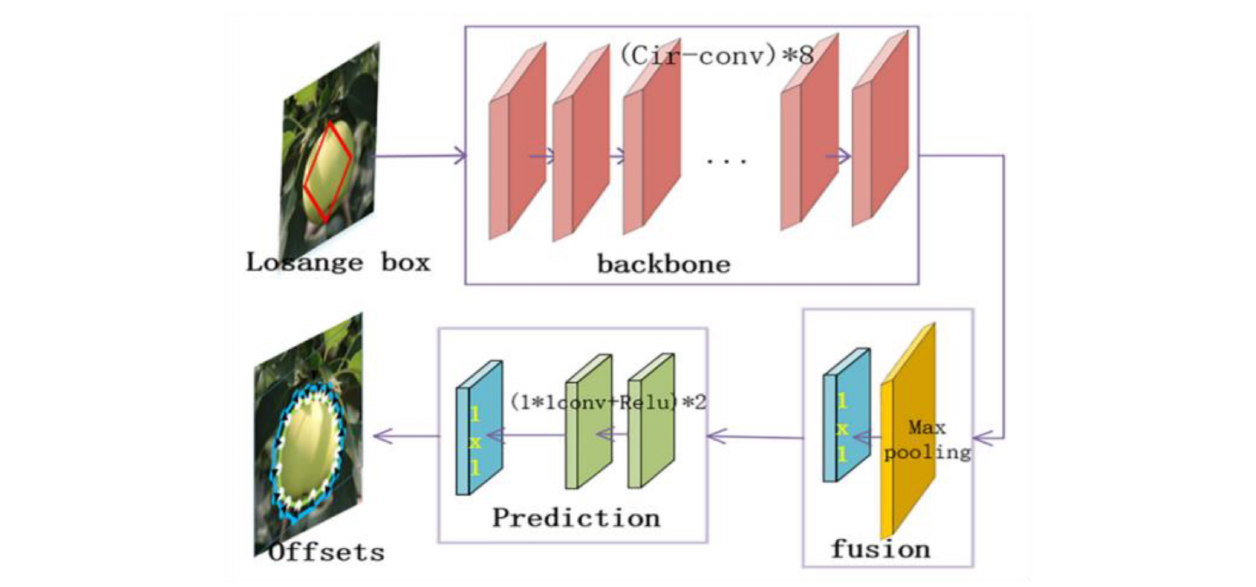
FIGURE 6 | Network structure of the add-on